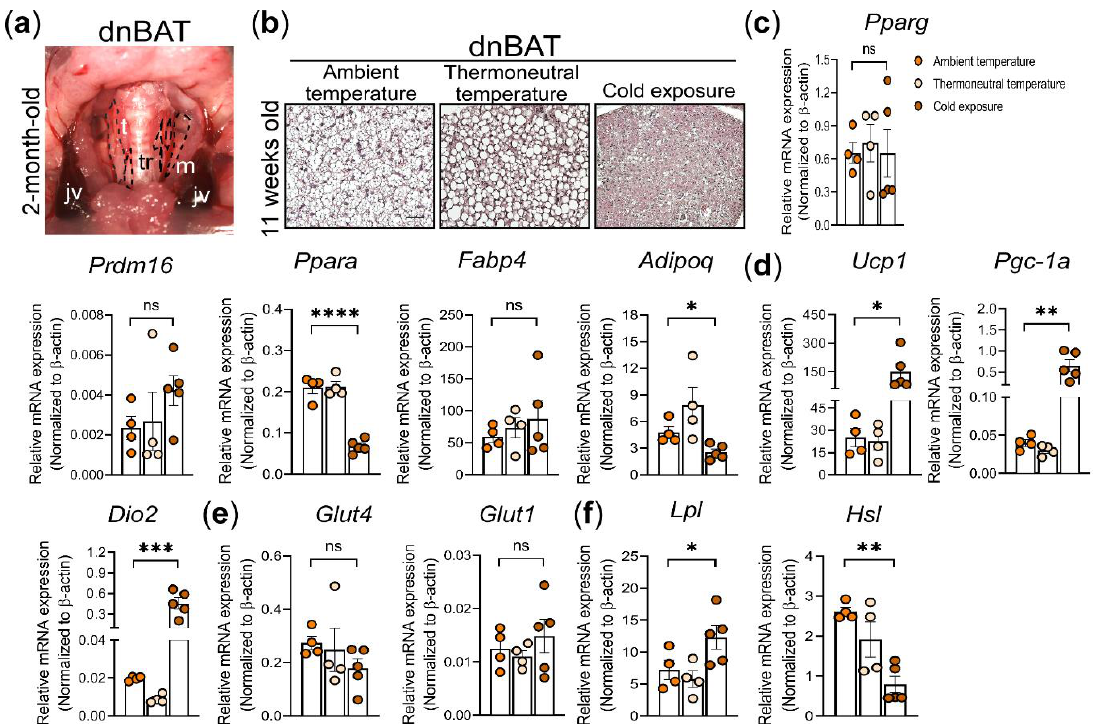
Figure 5. The effect of thermoneutrality and cold exposure on the adipocyte morphology and gene expression of dnBAT in C57BL/6 mice. ( a ) Representative image of the anatomical location of dnBAT in 2-month-old mice. tr: trachea, t: thyroid, m: sternocleidomastoid muscle, jv: external jugular vein. dnBAT is outlined by the black dotted line. ( b ) Representative images of H&E-stained sections of dnBAT from mice housed at ambient, thermoneutral, and cold temperatures. n = 3. Scale bar = 50 µ m. ( c – f ). RT-qPCR analysis of adipocyte differentiation marker genes, thermogenic genes, glucose uptake genes, and lipid-processing genes in scBAT, iBAT, iWAT, and eWAT depots from mice housed at ambient and thermoneutral temperatures and under acute cold exposure. ( c ) Adipocyte differentiation markers, Pparg , Prdm16 , Fabp4 , and Adipoq . ( d ) Thermogenic genes, Ucp1 , Pgc-1 α , and Dio2 . ( e ) Glucose transporters, Glut4 and Glut1 . ( f ) Lipid uptake and processing genes, Lpl and Hsl . The expression of these genes is normalized to the housekeeping gene β -actin. Data are presented as mean ± SEM. n = 4–5 for each group. * p < 0.05, ** p < 0.01, *** p < 0.001, **** p < 0.0001, ns =